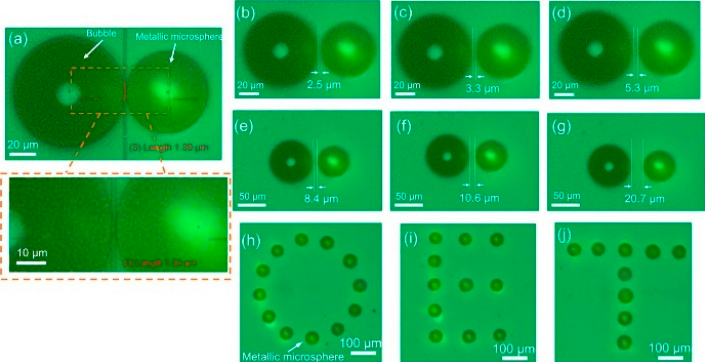
Figure 7. Captured images of manipulated metallic microparticles with different spaces to a bubble: ( a ) 1.39 µ m, ( b ) 2.5 µ m, ( c ) 3.3 µ m, ( d ) 5.3 µ m, ( e ) 8.4 µ m, ( f ) 10.6 µ m, and ( g ) 20.7 µ m; parallel assembly of metallic microspheres into images of ( h ) “O,” ( i ) “E,” ( j ) “T” (reproduced from Ref. [60]).